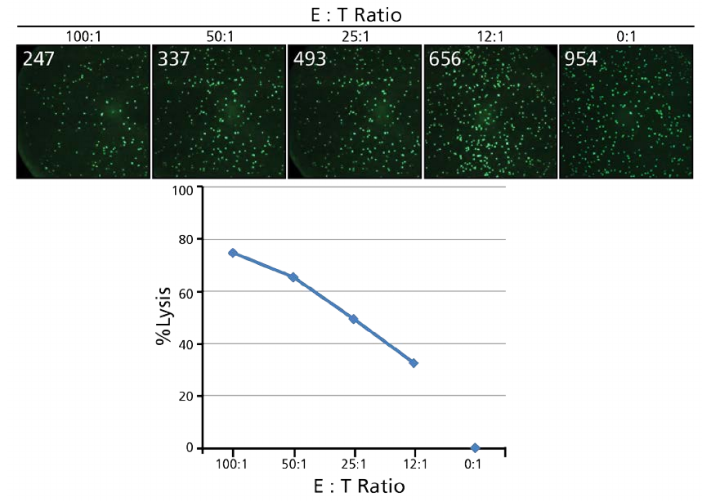
Figure 2. An example of the calcein-based TVA assay. A fixed number of calcein-labeled K562 target cells (5000/well) was incubated with effector cells (PBMC) at the specified effector: target (E:T) ratios in a round bottom 96 well plate for 4 hours. Subsequently, the cells were resuspended, and 3 × 50 µ L from each assay well were transferred into triplicate wells of a flat bottom plate for imaging and counting in an ImmunoSpot ® S6 FlouroCore Reader with the NK-TVA™ Software (by CTL). The numbers of live cells counted per well are superimposed on the images. Negative control wells that contain target cells but no effector cells establish the zero killing control value. The difference in viable cell counts is expressed and plotted as % lysis as the function of the E:T